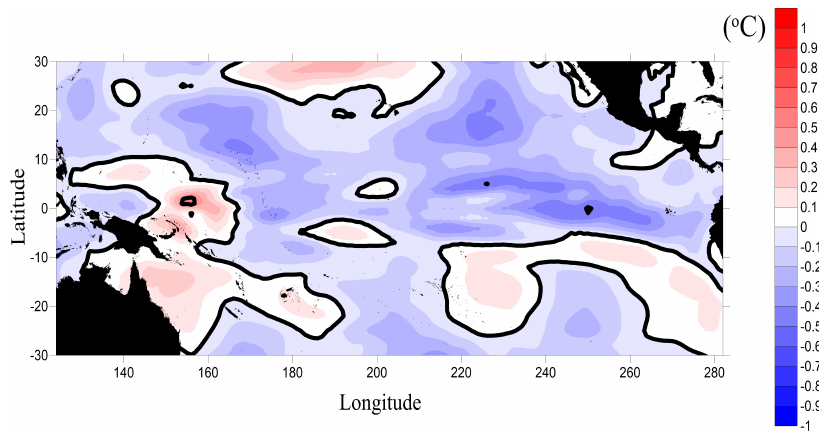
Figure 5. Difference between EICM and CIEICM SSTA data in January